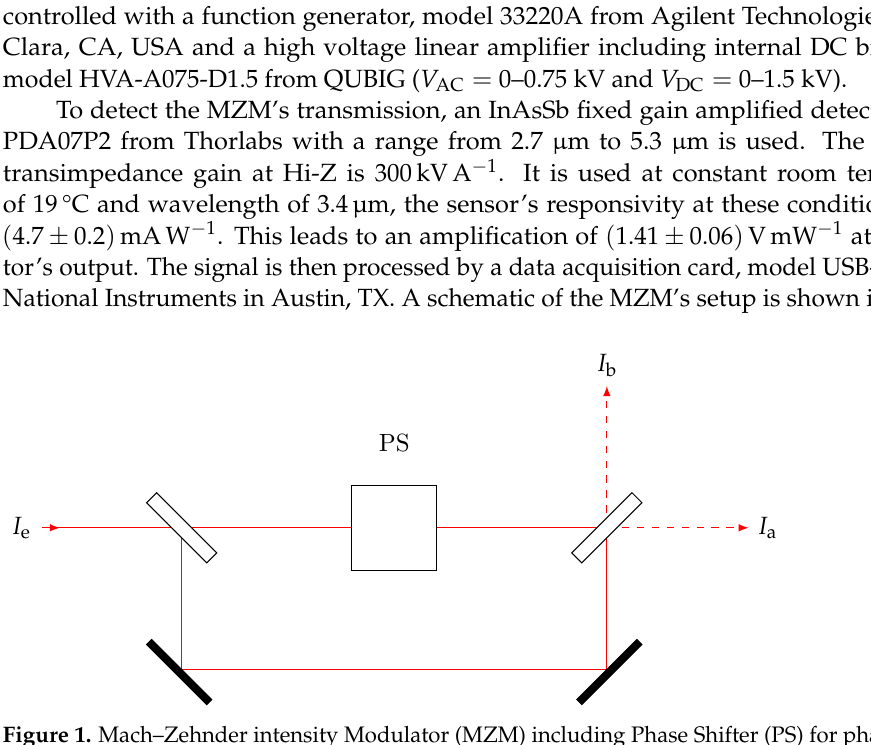
Figure 1. Mach–Zehnder intensity Modulator (MZM) including Phase Shifter (PS) for phase modula- tion, input I e , and outputs I a and I b